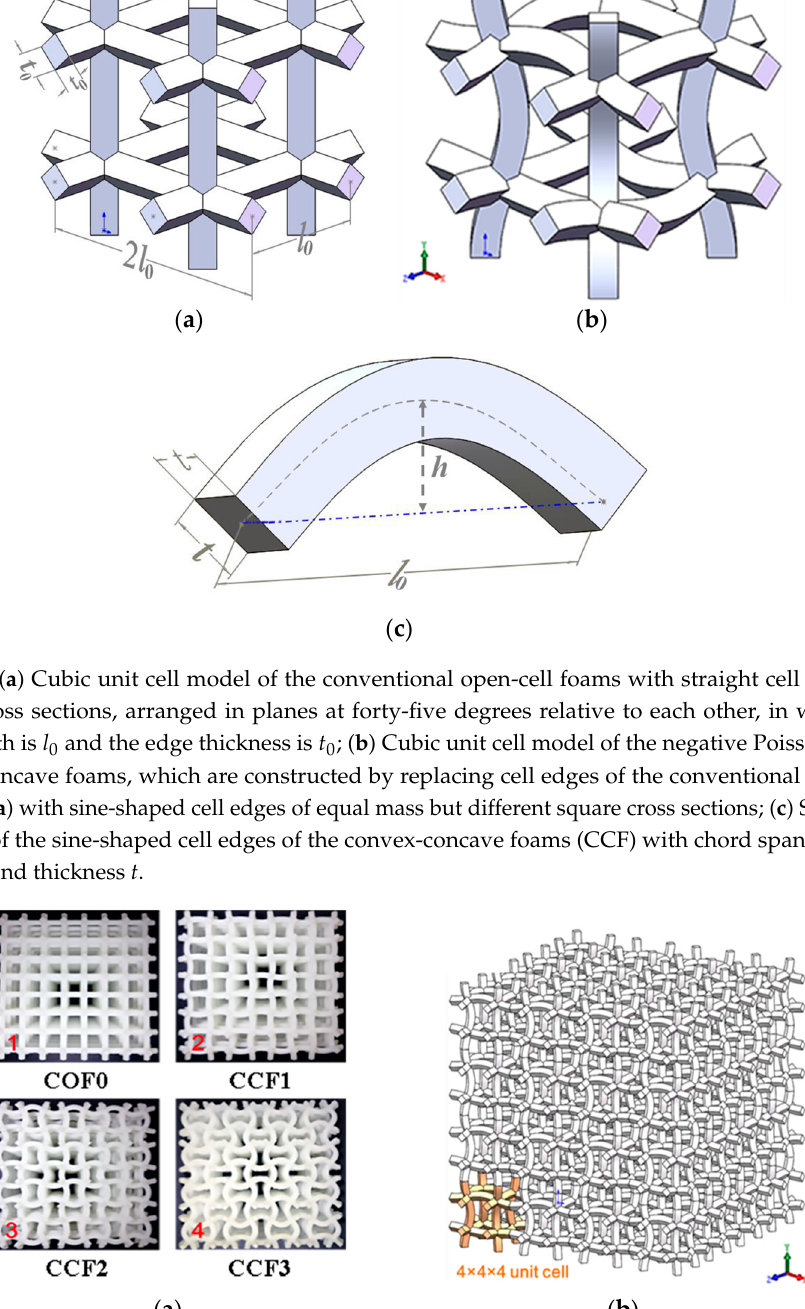
Figure 2. ( a ) Front views of the COF sample and the corresponding three kinds of CCF samples of equal mass: ( a1 ) COF0 ( t 0 = 1 mm, l 0 = 10 mm); ( a2 ) CCF1 ( h = 1 mm); ( a3 ) CCF2 ( h = 2 mm); ( a4 ) CCF3 ( h = 3 mm); ( b ) Schematic diagram of the CCF samples constructed by 4 × 4 × 4 arrays of the cubic unit cell shown in Figure 1b.